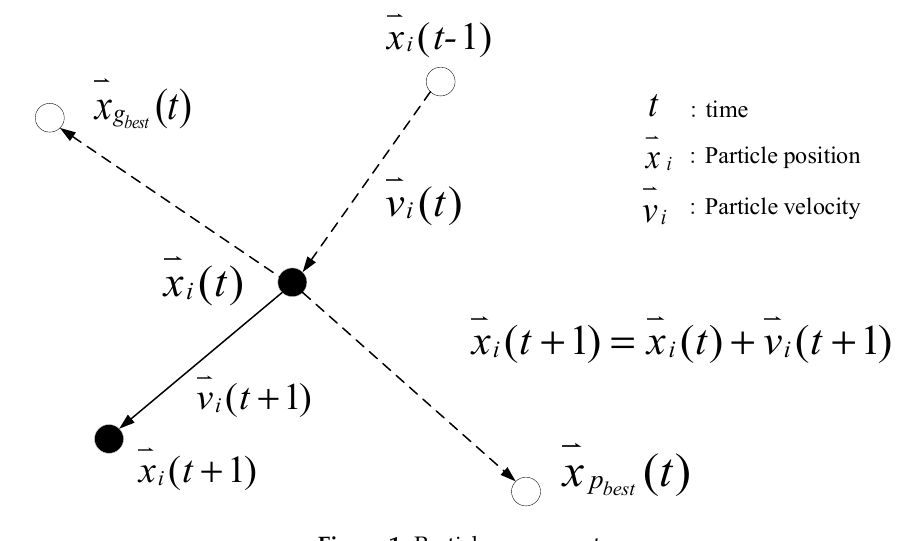
Figure 1. Particle movement.